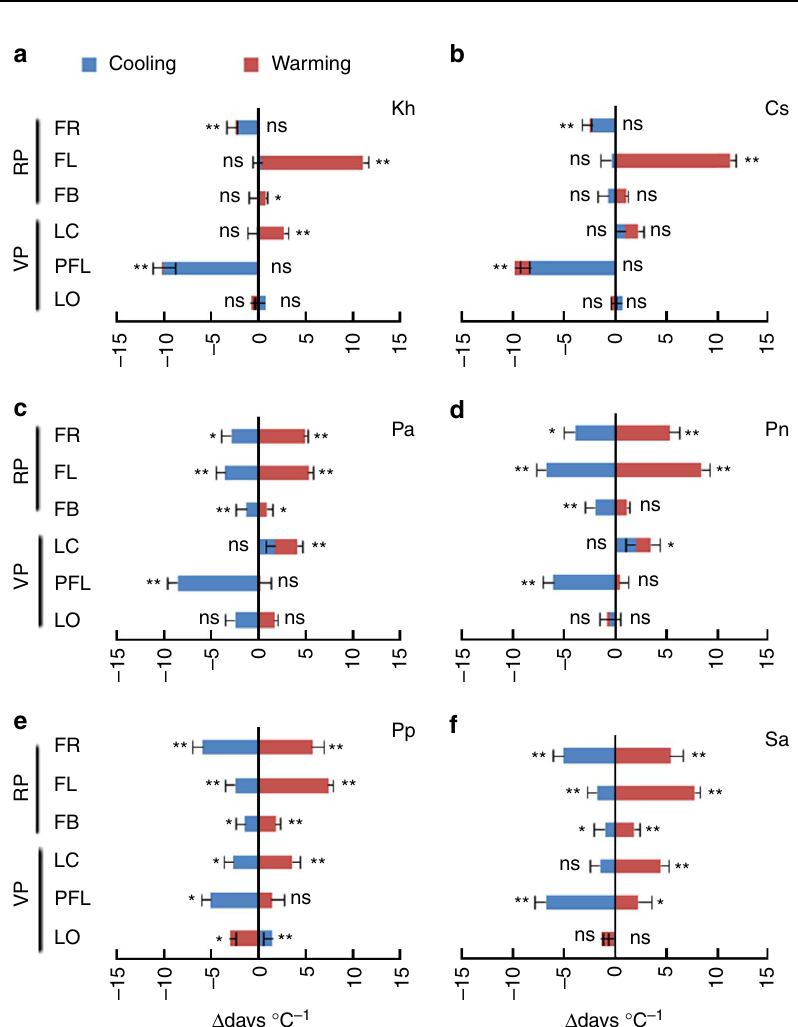
Figure 3 | Temperature sensitivity of duration change of individual phenological stages. The panels include six phenological stages of each species under warming and cooling ( D days (cid:2) C (cid:2) 1 ). VP, vegetative phase; RP, reproductive phase; LO, leafing-out; PFL, post-fruiting leaf; LC, leaf colouring; FB, fruit bud; FL, flowering; FR, fruit-set/seeding. D days was the difference between receptor site (that is, away site) and donor site (that is, homesite). Positive and negative values were prolonged and shortened phenological duration when transferred compared with donor site, respectively. Kh, K. humilis ( a ); Cs, C. scabrirostris ( b ); Pa, P. anserine ( c ); Pn, P. nivea ( d ); Pp, Poa pratensis ( e ); and Sa, S. aliena ( f ). A t -test was used for each phenological event and species, and the a was